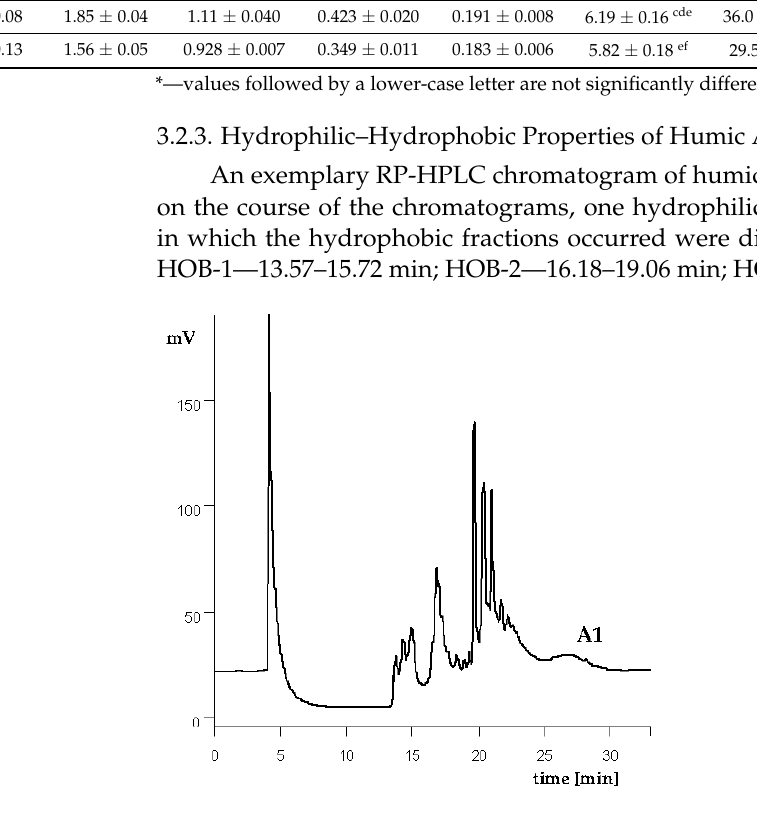
Figure 1. Selected RP-HPLC chromatogram of humic acids.